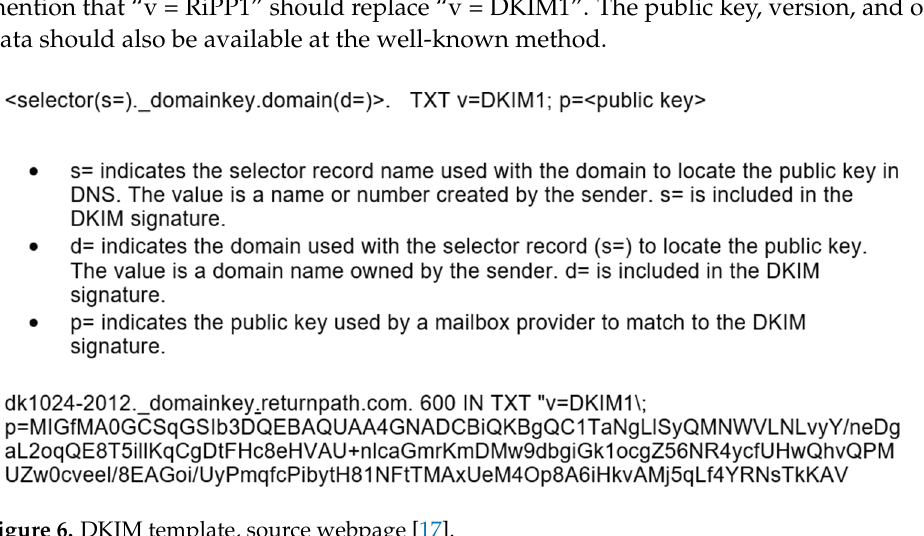
Figure 6. DKIM template, source webpage